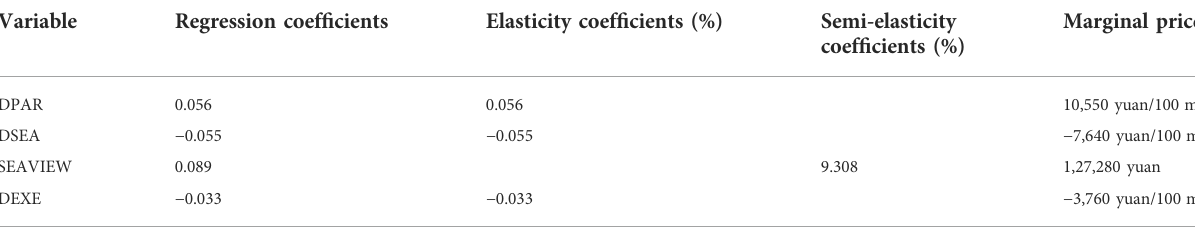
TABLE 4 The price elasticity/semi-elasticity of landscape